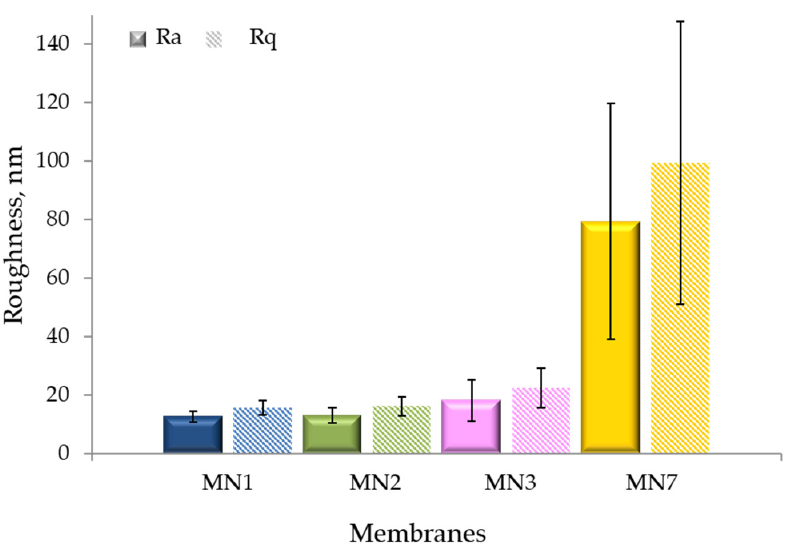
Figure 8. Surface roughness parameters for the prepared PVDF membranes (MN1, MN2, MN3 and MN7).